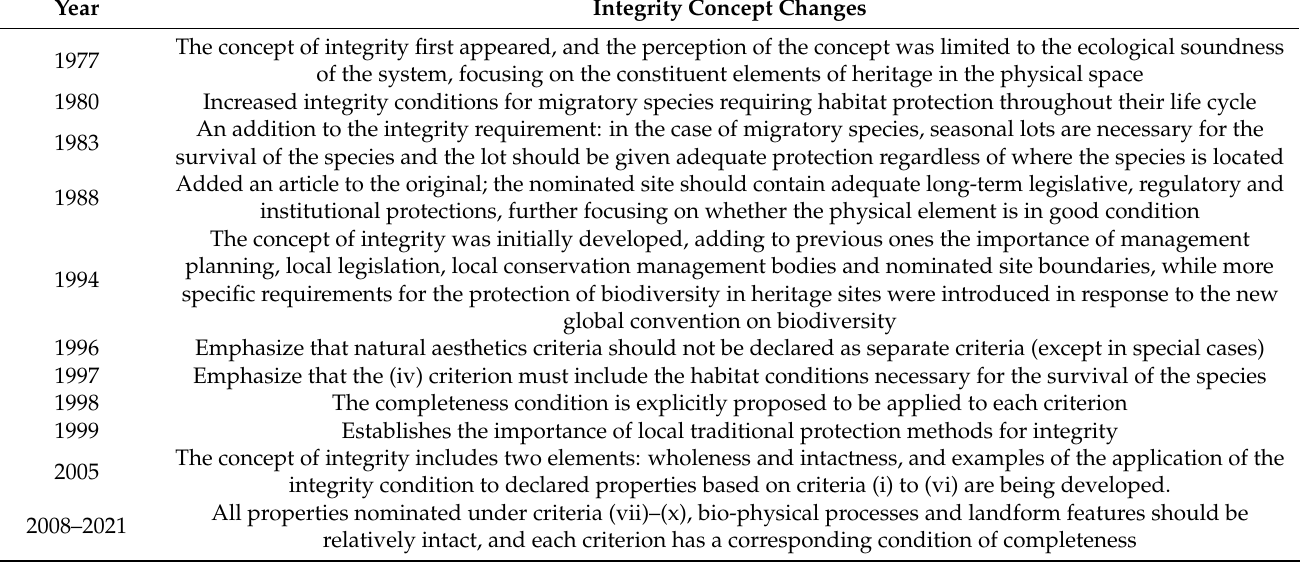
Table 2. Integrity concept